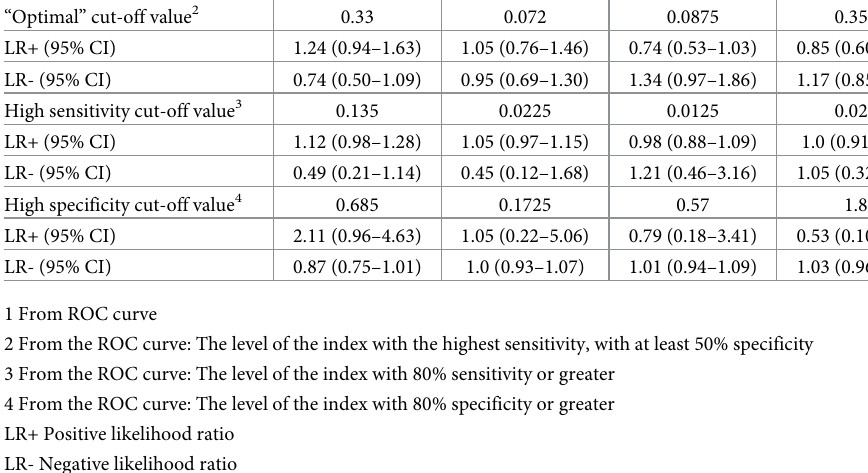
Fig 3. ROC curve for Breteau Index to predict dengue infection at cluster level. A. ROC curve for Breteau Index as a predictive test for dengue infection in all 150 clusters. B. ROC curve for Breteau Index as a predictive test for dengue infection in 75 trial intervention clusters. C. ROC curve for Breteau Index as a predictive test for dengue infection in 75 trial control clusters.